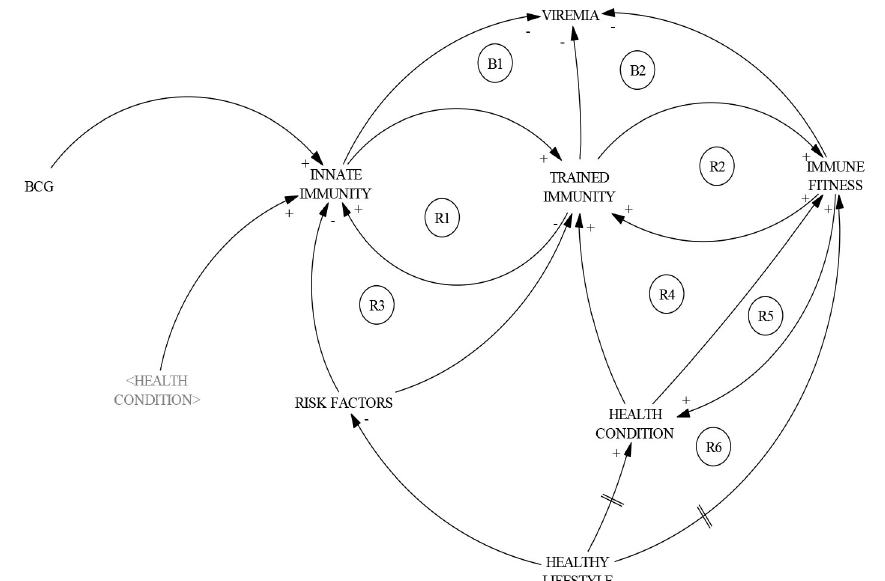
Figure 3. CLD representation of immune data caching. Regulation of innate immunity is the analogy of data caching. This CLD was inspired in Bekkering et al. [19], Burgos-Salcedo et al. [16], and Klement [8]. Cross activation of innate immunity by BCG, influenza, and meningococcal vaccines requires the action, predominantly, of reinforcing sub-cycles (R1–R6), involving, as a baseline, good health conditions derived from a healthy lifestyle. The symbol (//) represents a time delay in the action between two components of the